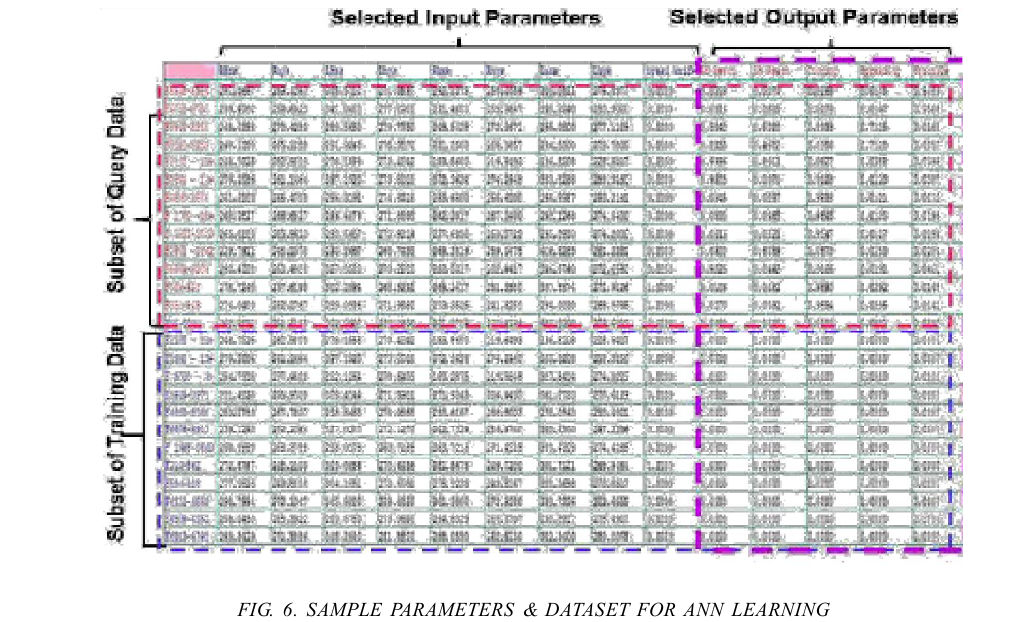
FIG. 6. SAMPLE PARAMETERS & DATASET FOR ANN